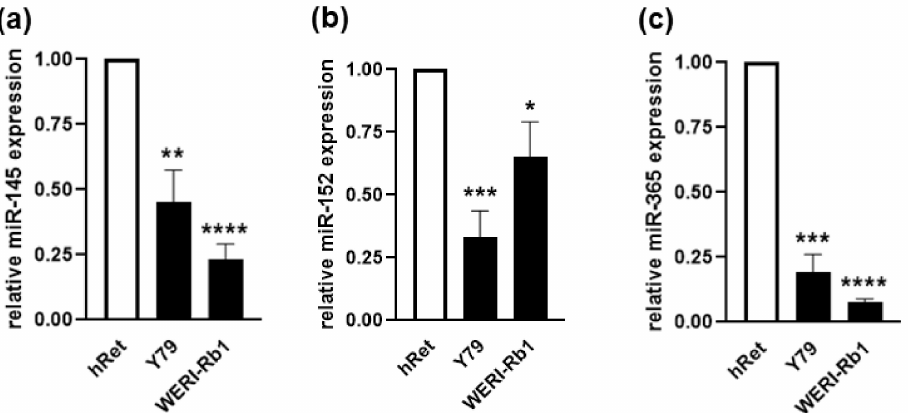
Figure 10. MiRNA-145, miRNA-152 and miRNA-365 expression levels in parental WERI-Rb1 and Y79 cell lines as revealed by real-time PCR ( a – c ). Values are means of at least three independent experiments ± SEM. * p < 0.05; ** p < 0.01; *** p < 0.001; and **** p < 0.0001 statistical differences compared to the control group calculated by Student’s t -test.